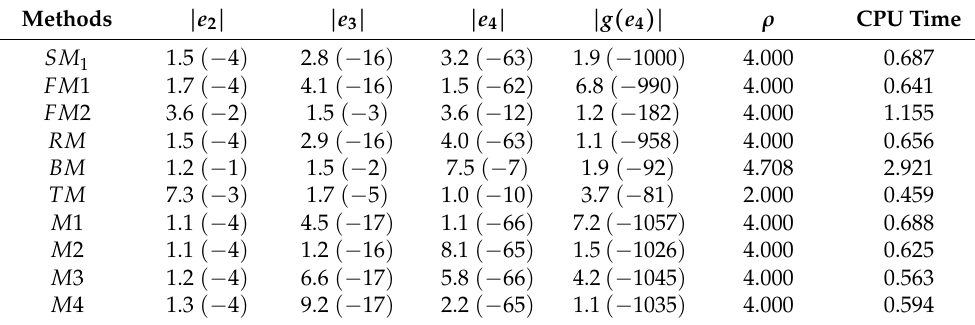
Table 5. The outcomes of Example 4 based on various methods with starting point x 0 = 1.2 i